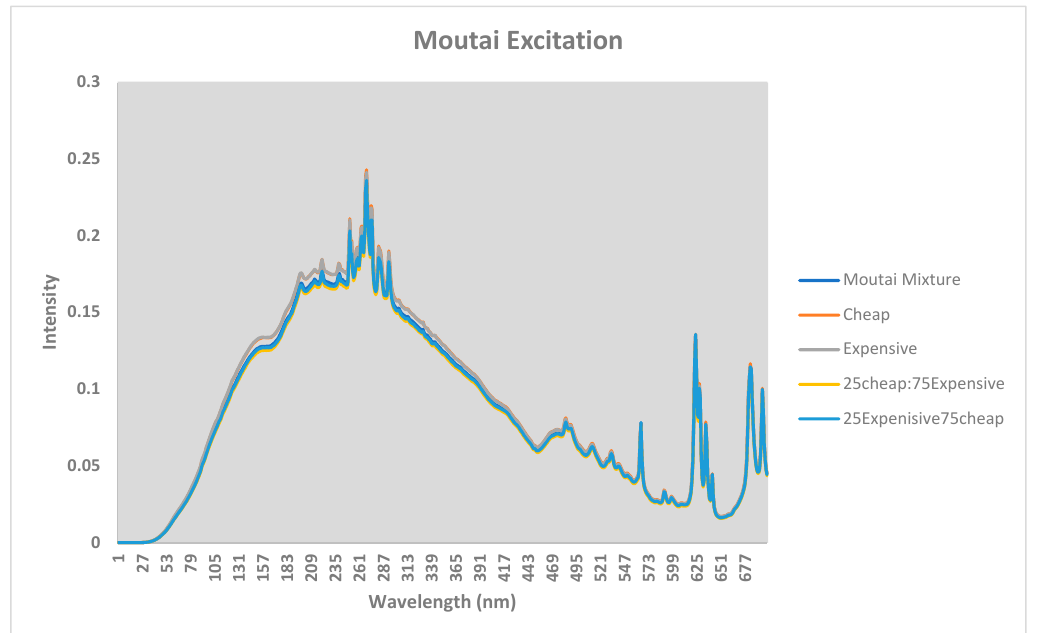
Beverages 2021 , 7 , x FOR PEER REVIEW Figure 3. Moutai excitation of different ratios of inexpensive to expensive Moutai spirits.